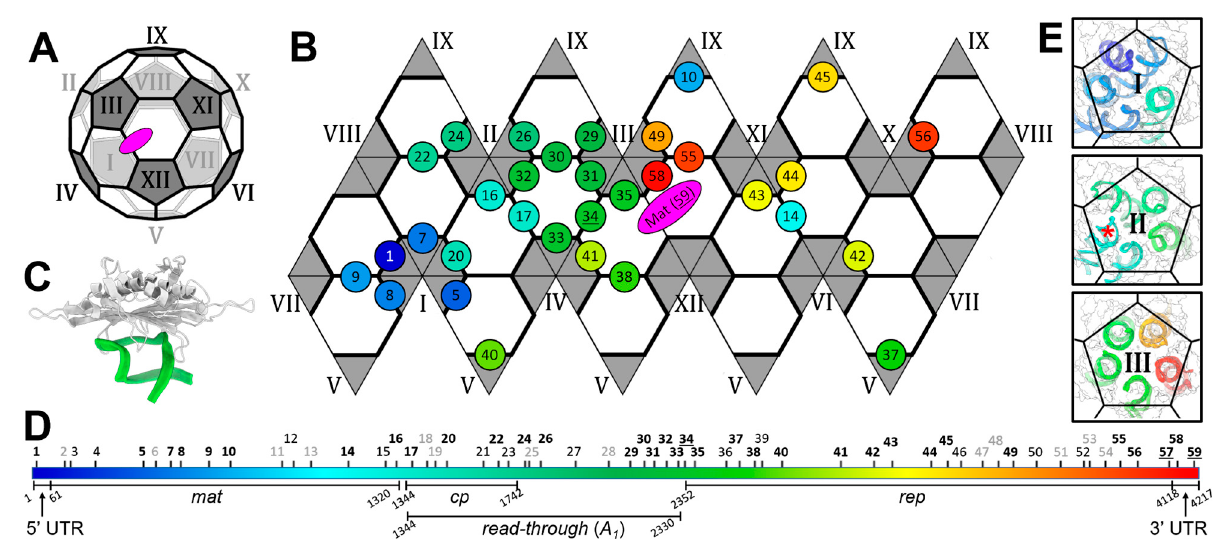
Figure 2. Operator-like RNA stem-loops in the gRNA that interact with the capsid shell. ( A ) The near icosahedral capsid of the Q β is illustrated as a cage with the Mat labeled as a magenta oval. The twelve pentamers are dark grey, and labeled from I to XII. ( B ) The cage is unwrapped to display the capsid as a 2D map, with each thick line representing a CP dimer. The asymmetric A/B dimer is between a grey pentamer and a white hexamer. The symmetric C/C dimer is between two white hexamers. The rainbow-colored circles label the operator-like stem-loops from the 5 ′ (blue) to 3 ′ (red) ends of the gRNA. ( C ) A model showing an operator-like RNA stem-loop interacting with a CP dimer. ( D ) The sequence of the Q β gRNA is rainbow-colored. The UTRs, the genes of maturation protein (mat), coat protein (cp), replicase (rep), and A 1 protein (read-through or A 1 ) are labeled. The 59 stem-loops, which have a distance of less than 5 Å to the capsid proteins, are numbered and labeled on the sequence with operator-like (bold black), CP-sandwiched (black), and CP-anchored (grey) stem-loops labeled. The actual translational operator and the stem-loop that interacts with the internal CP dimer are labeled by the underlined numbers 34 and 57, respectively. The underlined 59 indicates the stem-loop which interacts with the Mat. ( E ) The operator-like RNA stem-loops (rainbow-colored) interact with the CPs in Pentamers I, II, and III. The red star labels one CP-sandwiched RNA stem-loop (number 15 in Pentamer II).